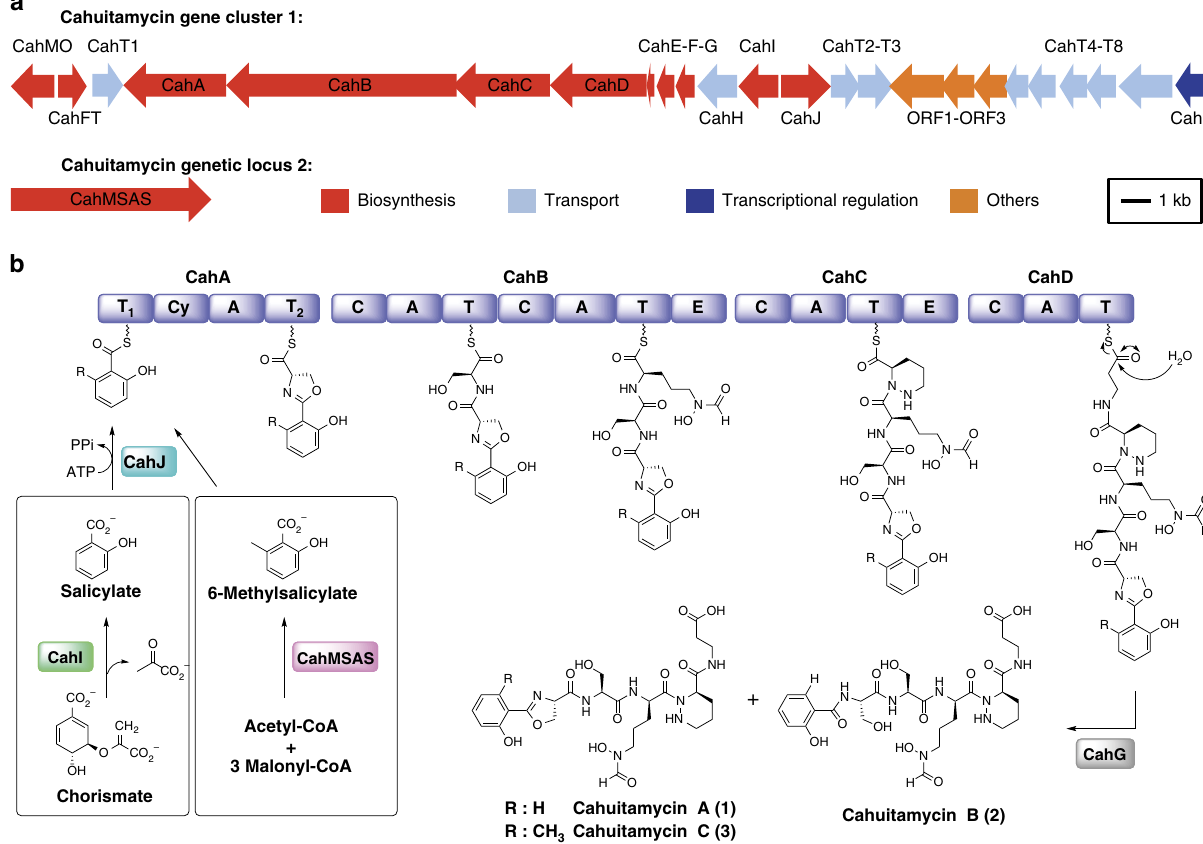
Figure 2 | Complete biosynthetic scheme of cahuitamycins. Organization of the bifurcated cahuitamycin ( cah ) gene cluster ( a ) and a